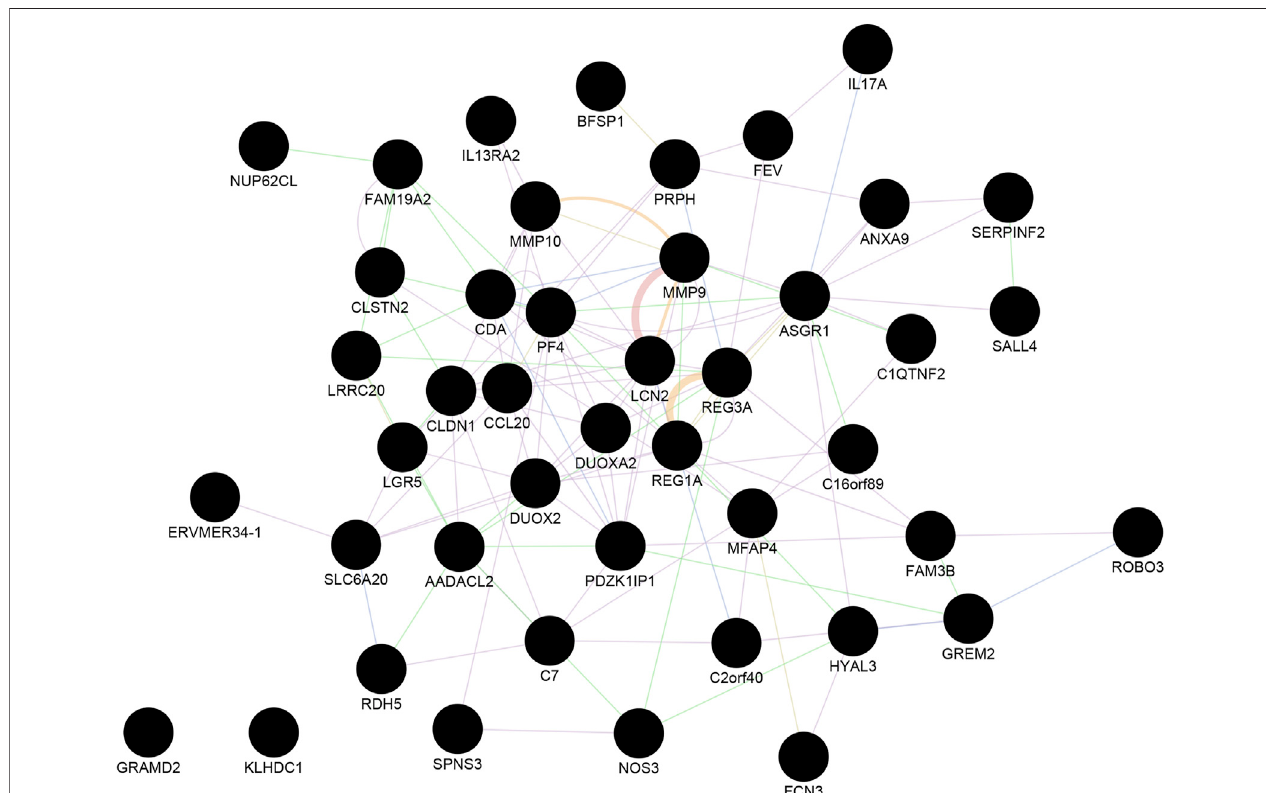
FIGURE 2 | The shared gene modules between CRC and IBD. A total of 48 shared hub genes (cancer compared with normal tissue; IBD compared with normal samples) were identi fi ed and imported to GeneMANIA to construct a co-expression and gene interaction network. Each circle represents a gene. Each edge (line) representsinteractionsbetweentwogenes.Multiplelinescorrespondtomultiplesources,asindicatedbythecolorcoding.Seealso SupplementaryTablesS3,S4 for additional